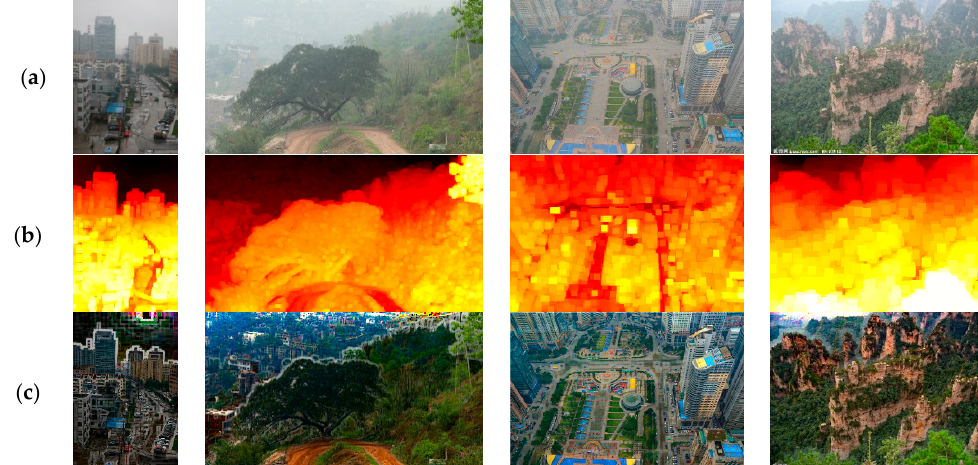
Figure 7. Hazy images, the corresponding rough transmission maps t α and the relevant recovered images. ( a ): hazy images. ( b ): the corresponding rough transmission maps t α . ( c ): the relevant recovered images.